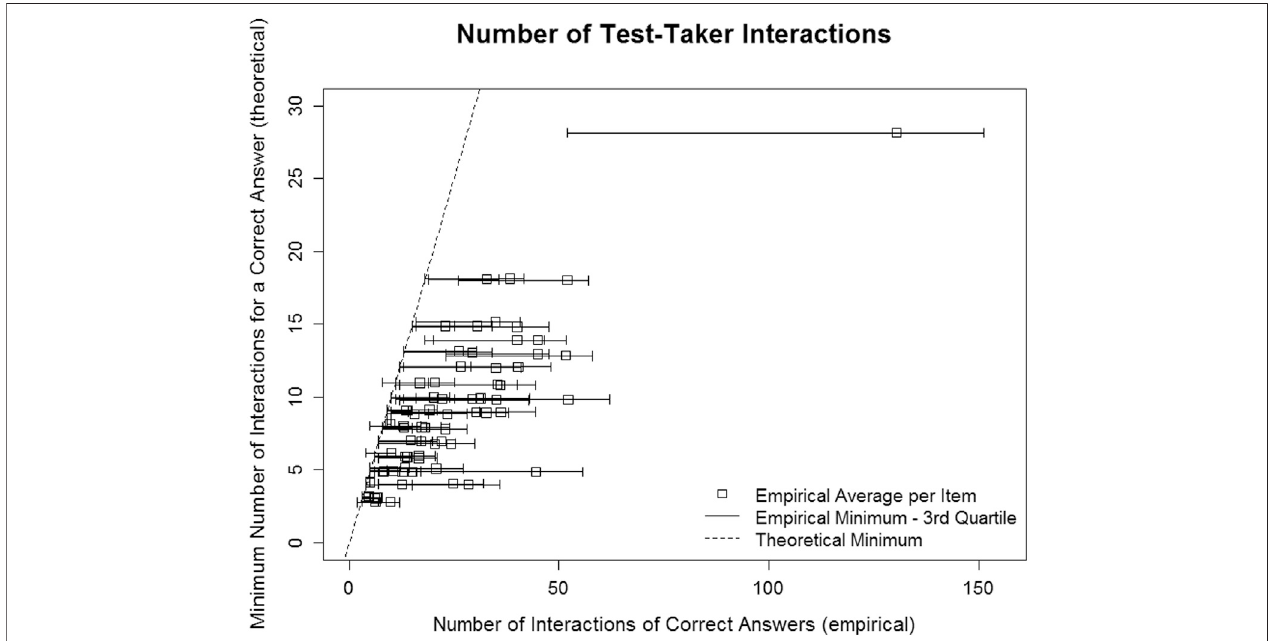
FIGURE 2 | Empirical number of test-taker interactions in correct item